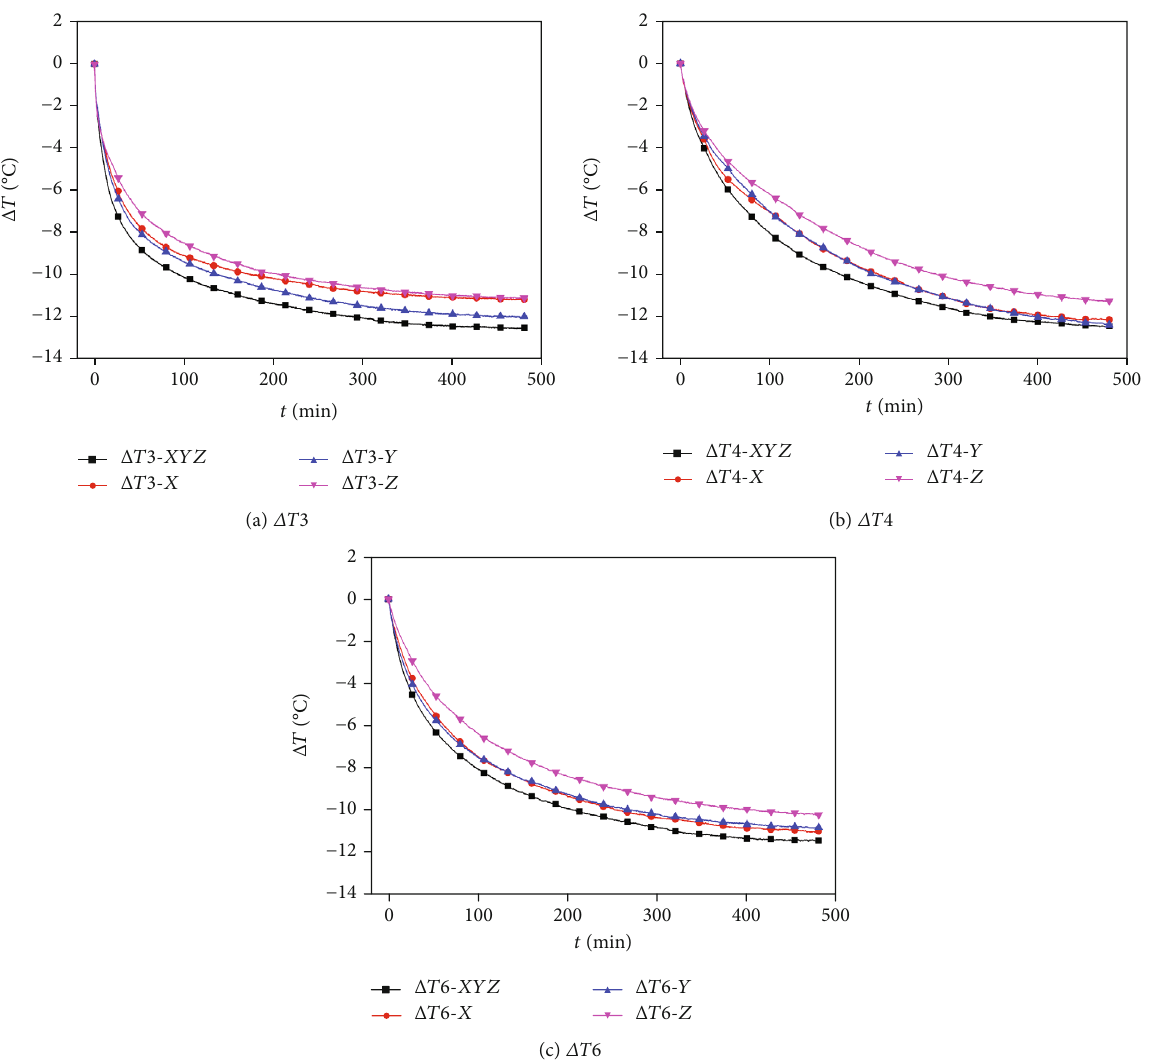
Figure 7: Variation of temperature under di ff erent unloading stress